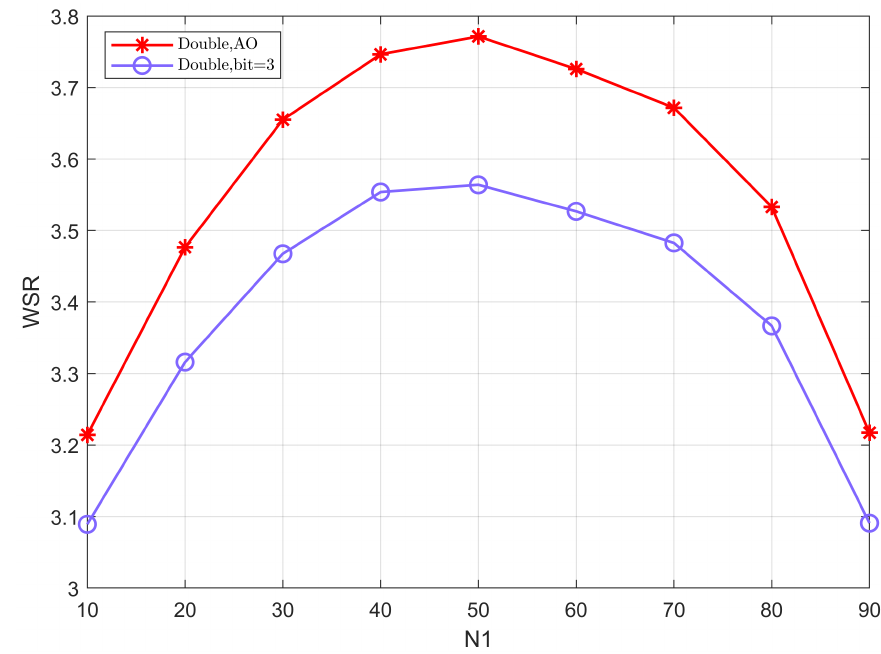
Figure 5. The WSR versus the number of the reflection elements N 1 assigned to IRS 1.